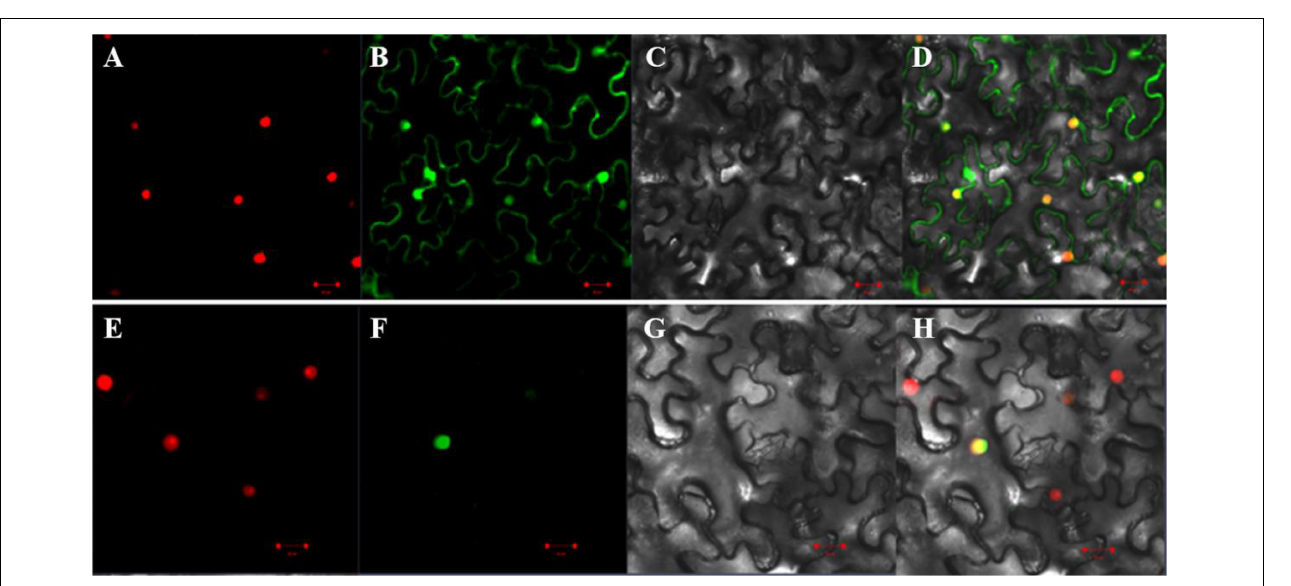
FIGURE 5 | Subcellular localization of GmAP2/ERF144. (A) 35S::PIP2;1-mCherry fusion protein. (B) 35S::EGFP fusion protein. (C) Bright-field. (D) Merged image of panels (A–C) . (E) 35S::PIP2;1-mCherry fusion protein. (F) 35S::GmAP2/ERF144-EGFP fusion protein. (G) Bright-field. (H) Merged image of panels (E–G) . Bar = 0.02